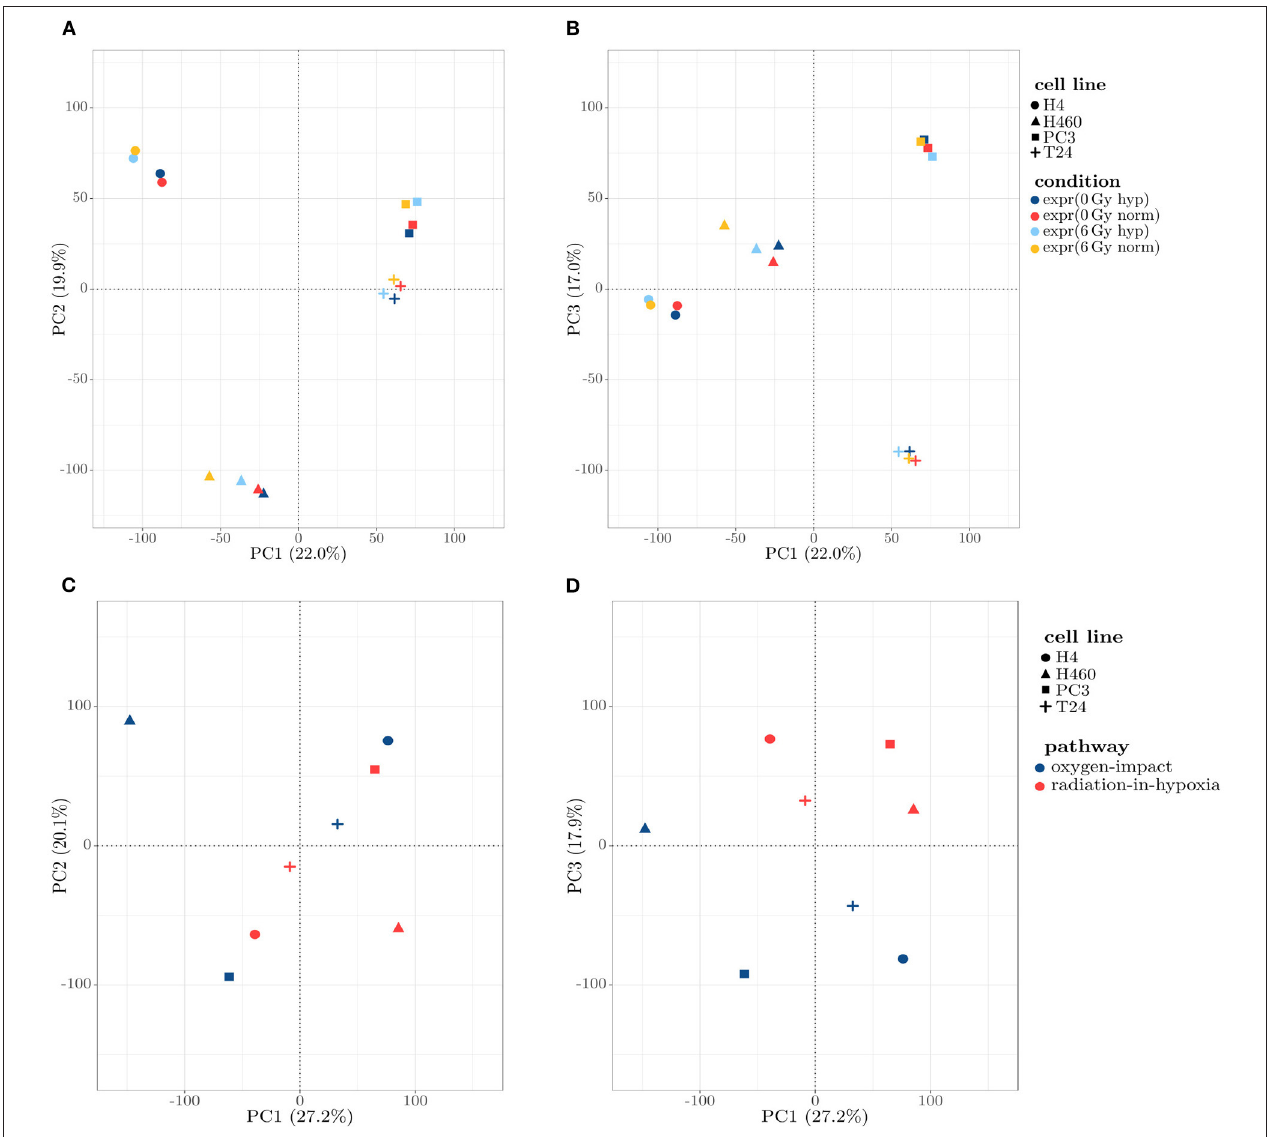
FIGURE 1 | (A,B) Scatter plot of the 16 samples, projected on the first three principal components (PCs) obtained by a PCA. (A) Projection on the first two PCs: a clear assignment of the samples toward four distinct clusters describing the cell lines can be observed. (B) Projection on the first and third PCs: similar to (A) , a clear separation between the cell lines is visible, with the third PC separating H4 and T24 from H460 and PC3 . (C,D) Scatter plots projecting the expression profiles on the principal components (PCs) obtained by a PCA, projected onto first and second PC (C) and first and third PC (D) : The clustering is shown to be independent of the cell line and dominated by the introduced profiles in the PC1/PC3 depiction (D)